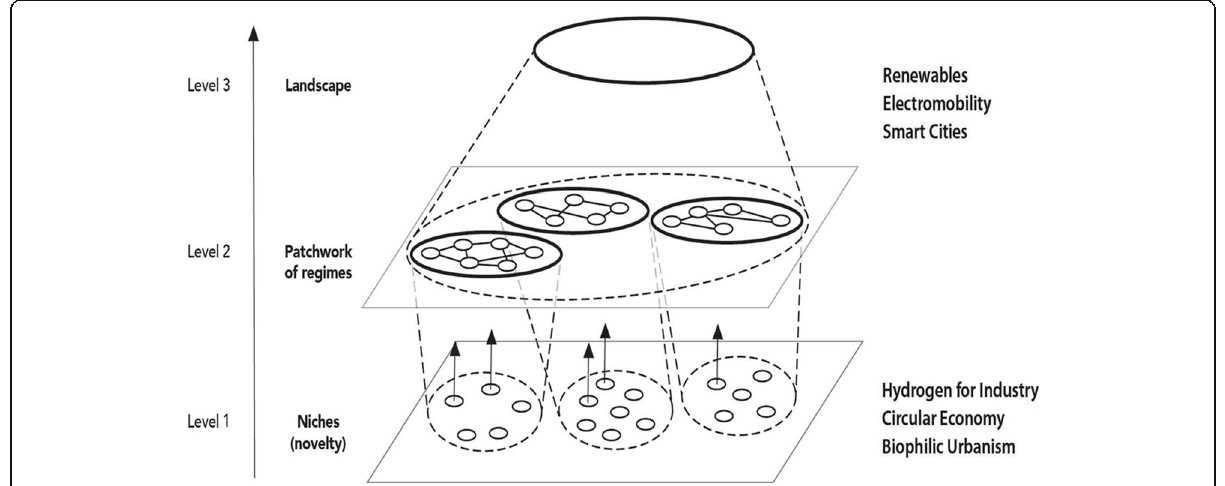
Fig. 10 The multi-level perspective of Transition Theory showing how technologies niches to regimes to mainstream landscapes [12,